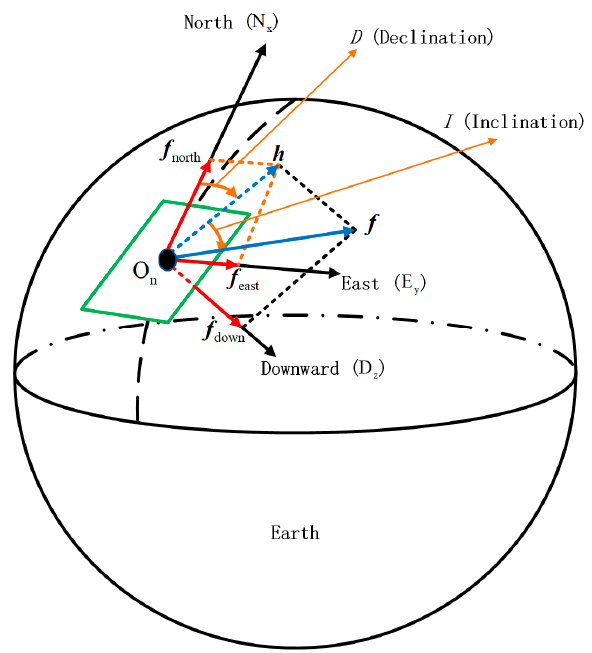
Figure 1. Description of geomagnetic field.